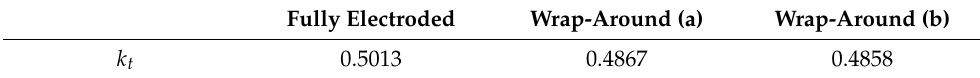
Table 3. Calculated values k t